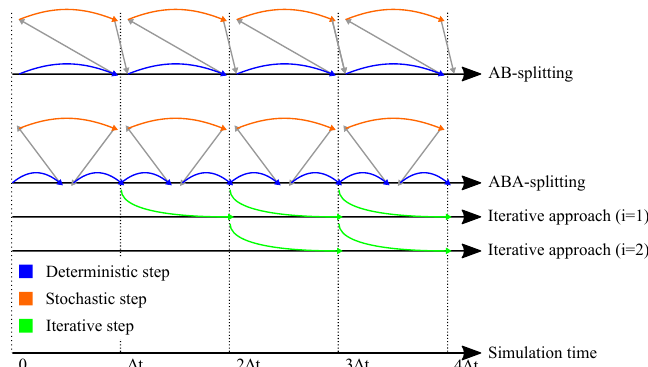
Figure 2. Illustration of how the iterative algorithms work in principle. The idea is a boot-strap algorithm, which improves the starting conditions of the iterative splitting approach. In the upper figure, we present the AB-splitting method. The first step is deterministic and the second step is stochastic. In middle figure, we present the ABA-splitting method. The first step is deterministic, the second step is stochastic step and the third step is deterministic, and we obtain a second order approach. In the lower figure, we have the iterative splitting approach of i = 1, which uses a second order starting condition of the ABA-splitting method and improves the results with an iterative step to higher order results. These results of the iterative splitting approach of i = 1 are used as a starting condition for the iterative splitting approach of i = 2, we also could improve the results with more accuracy and so on; see also